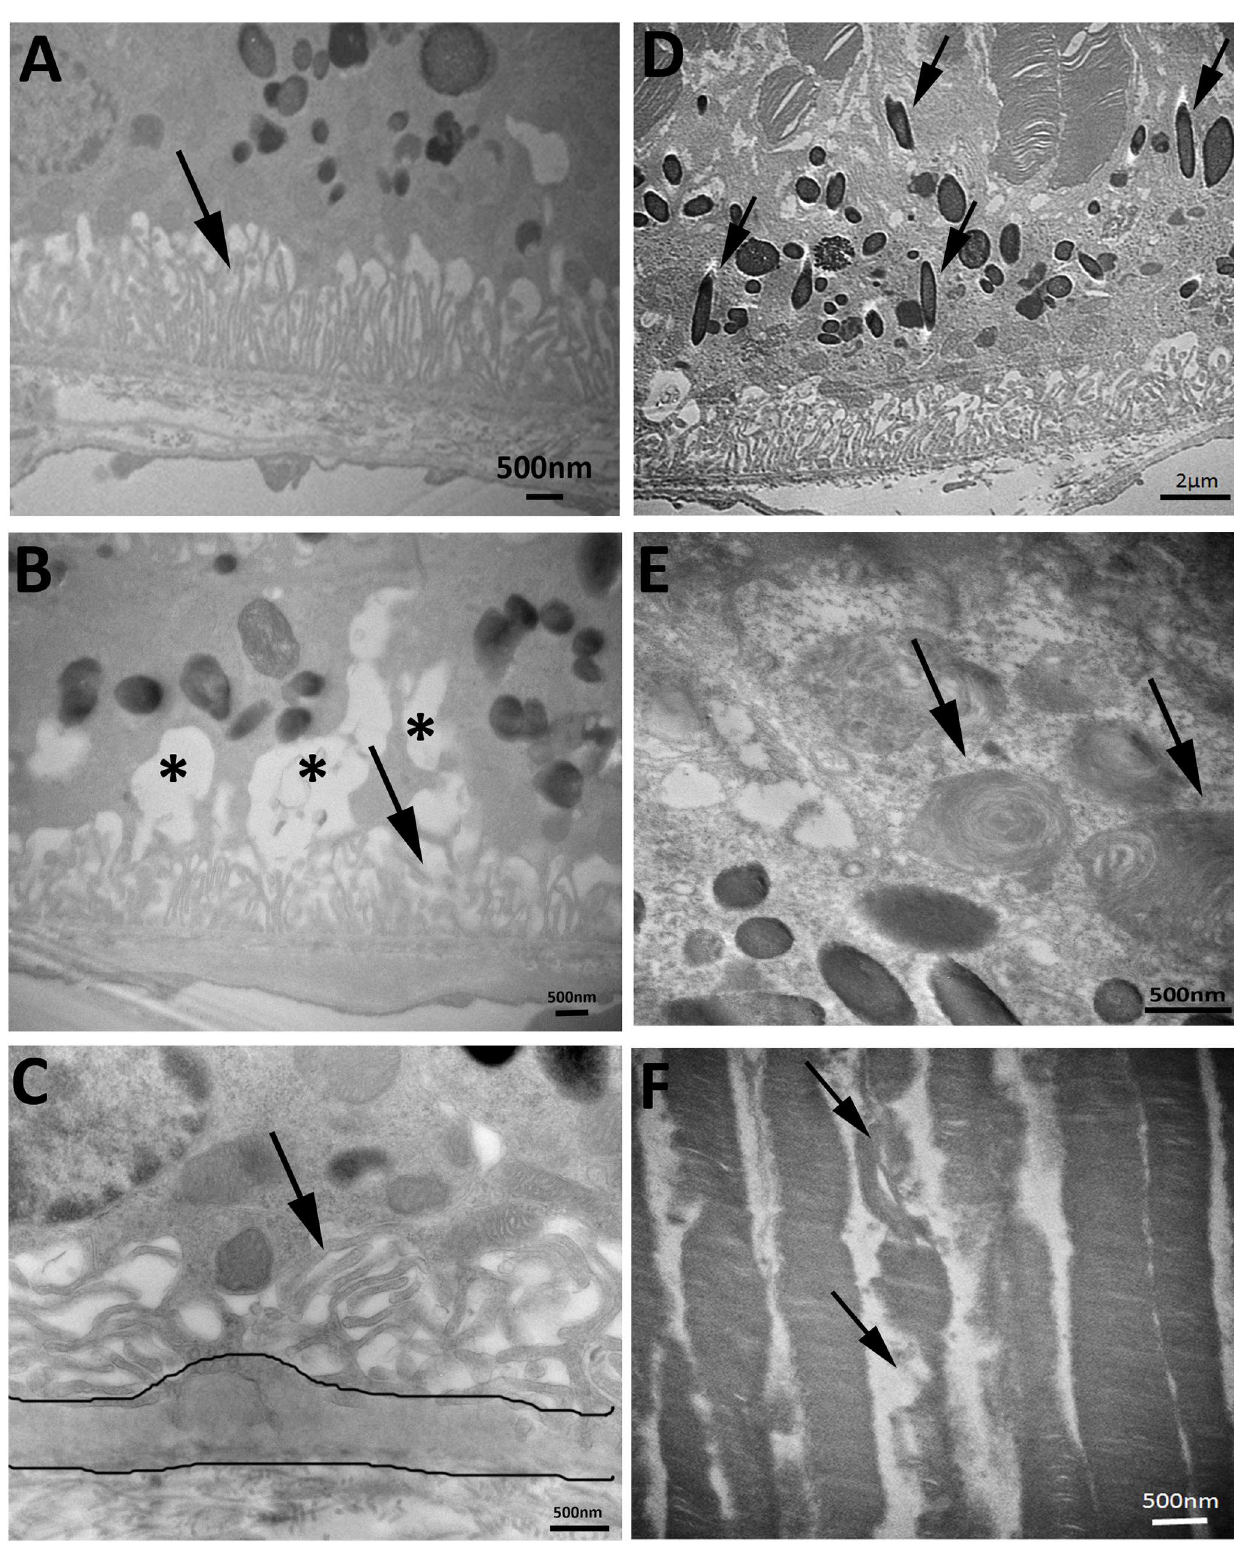
Fig 4. RPE ultra-structural changes in aged Cxcr5 -/- mice. (A) RPE of the adult (5 months old) Cxcr5 -/- mice. Arrows indicatednormal RPE basal infolding. (B) RPE vacuoleswith membranous debris inside (asterisks) and reducedbasal infolding (arrow) . (C) Disorganized basal